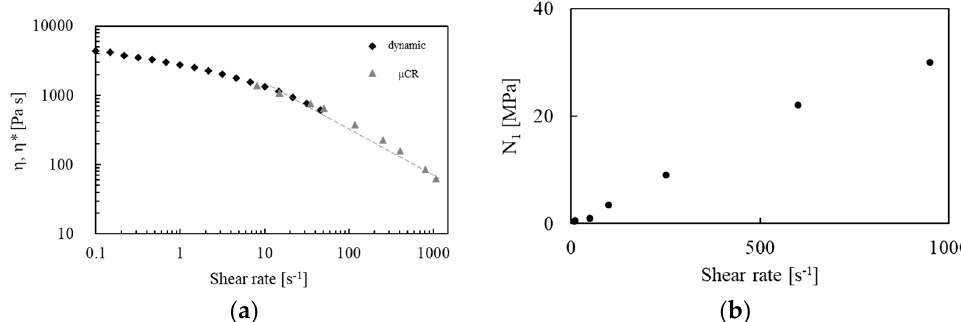
Figure 2. ( a ) Complex and shear viscosity as function of shear rate measured by dynamic (black rhombus) and capillary rheometer (grey triangles), the dashed line is the power law fitting; ( b ) normal stresses (N 1 ) as function of shear rate.